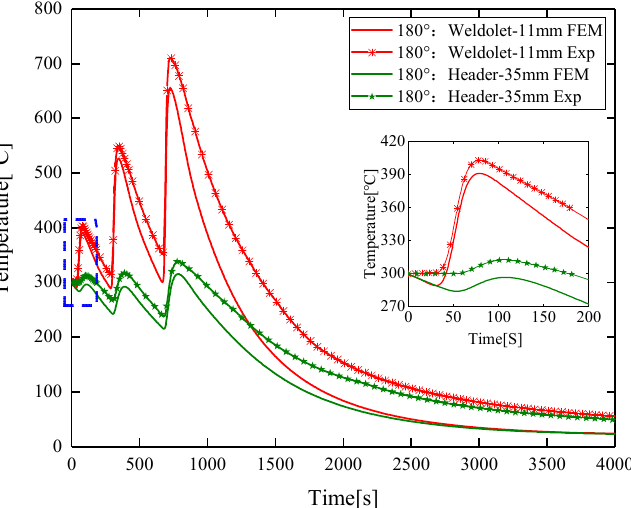
Figure 9. Comparison of the predicted and measured values of transient temperature changes on the outer surface of the weldolet and header.